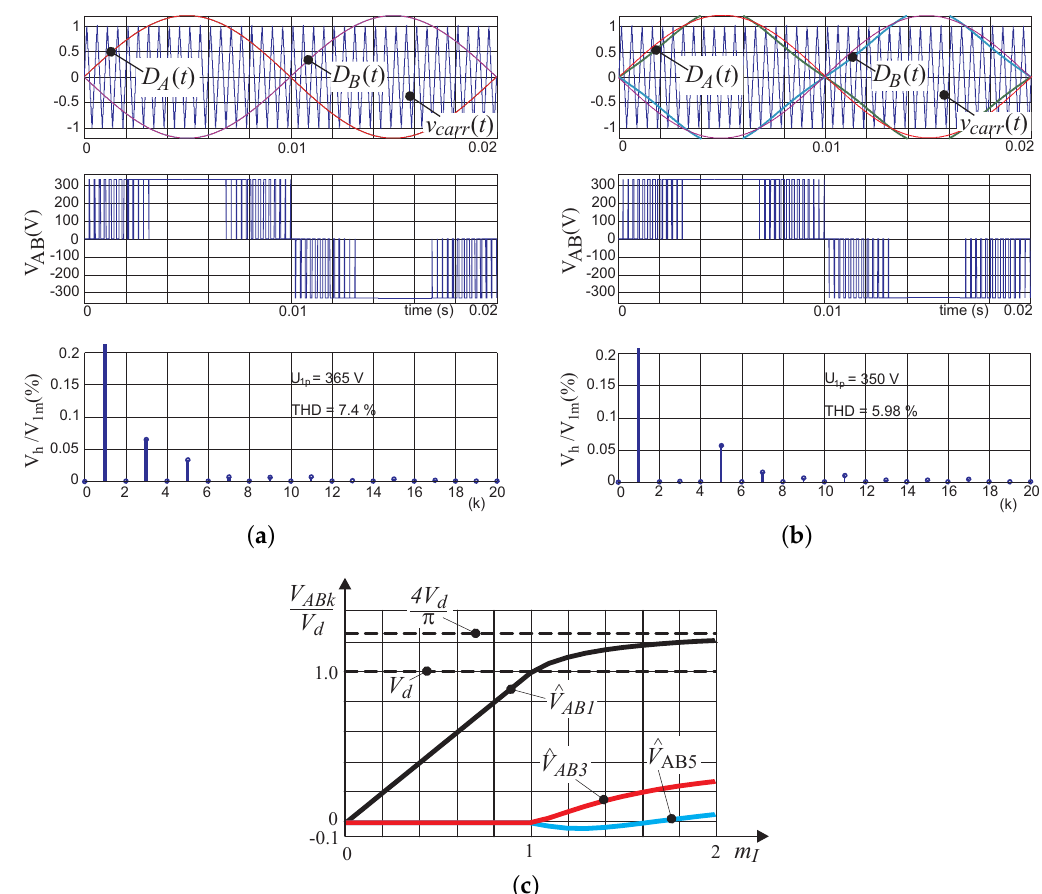
Figure 7. Over-modulated output voltage v ABom ( t ) and harmonics at m I = 1.2: ( a ) SPWM without compensation and ( b ) SPWM with third harmonic eliminated. ( c ) First, third and fifth harmonic components versus modulation index m I ∈ ( 0,2 ) for SPWM without compensation.